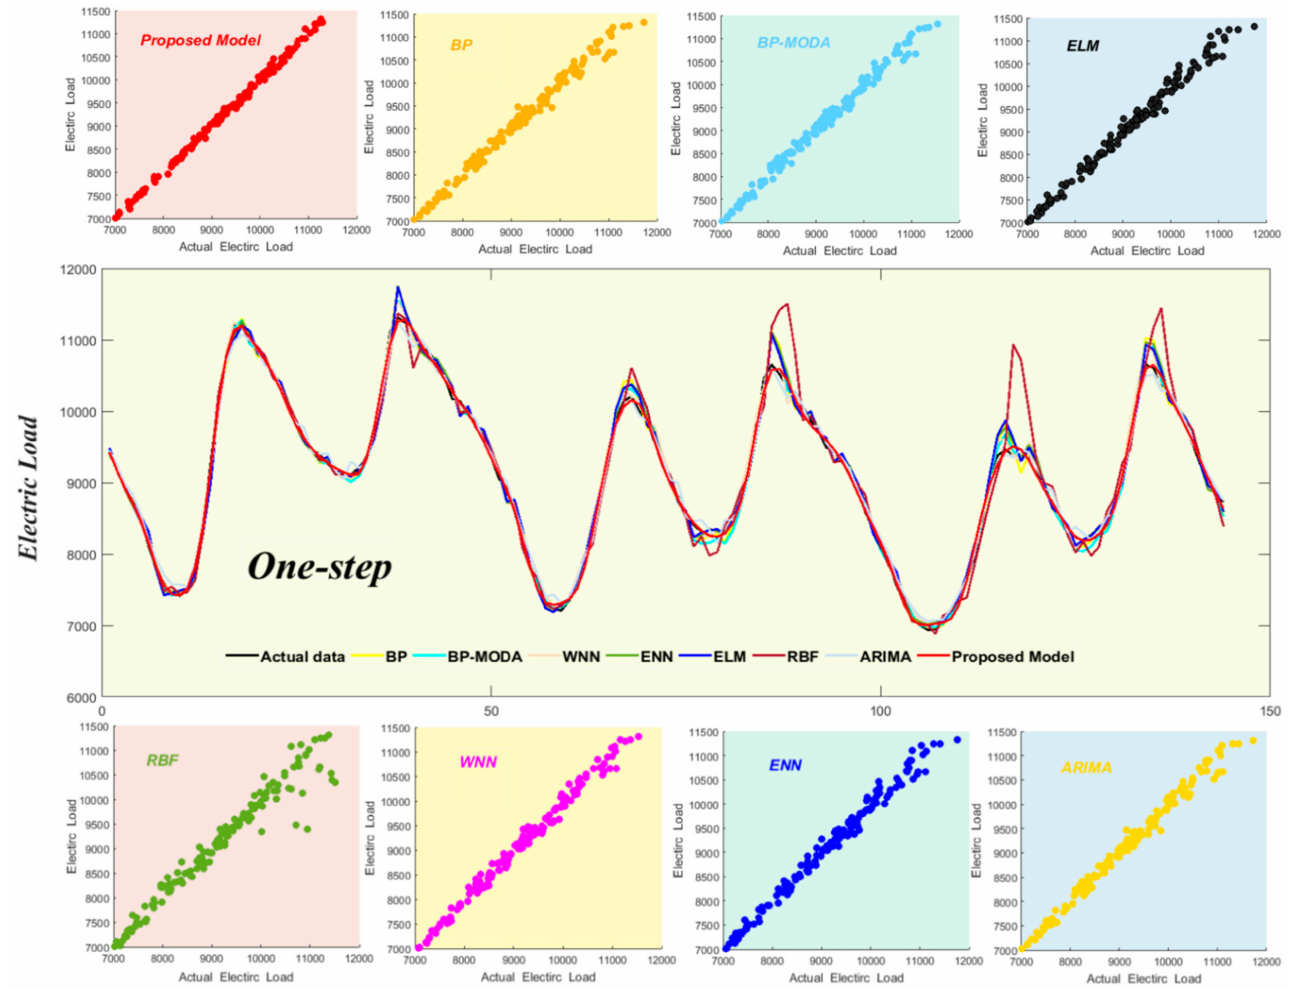
Figure 5. Comparison of one-step forecasting performance of Experiment III for New South Wales (NSW;